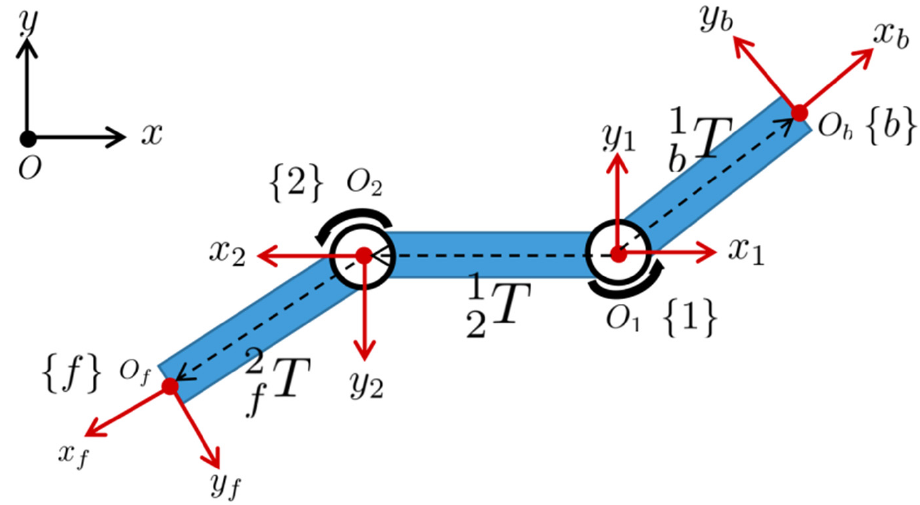
Figure 11. The kinematic model of the baby chair.